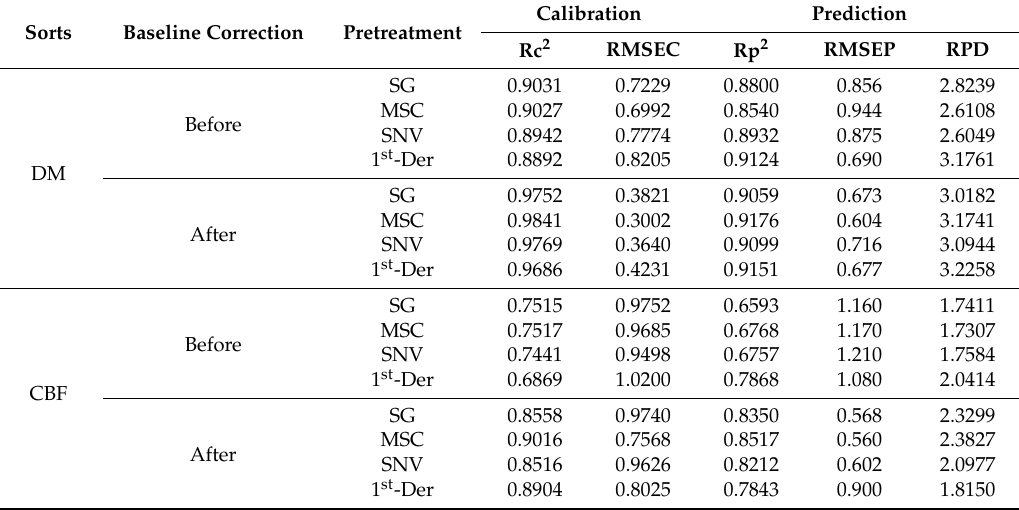
Table 3. PLS modeling results based on the full spectra under different